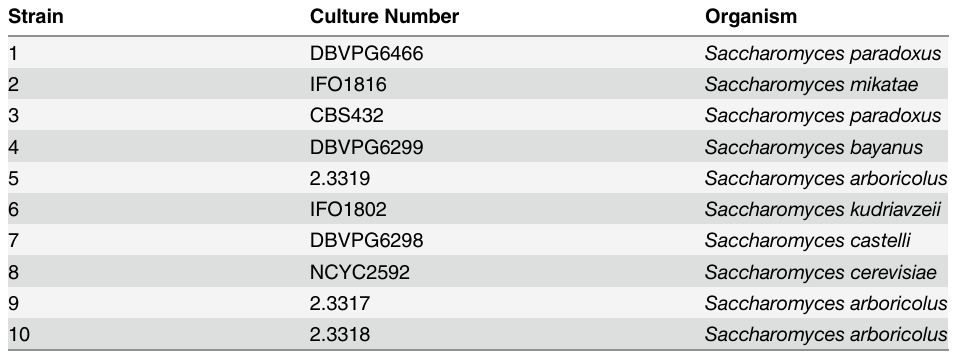
Table 1. Strain number and names of Saccharomyces spp. used in the study. Strain Culture